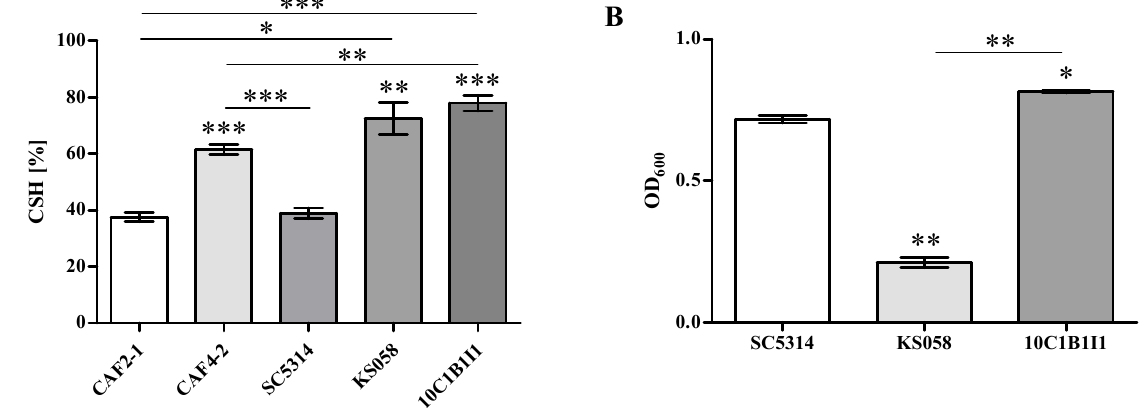
Figure 1. The cell surface hydrophobicity (CSH) and biofilm formation of C. albicans strains. ( A ) CSH (%) of C. albicans strains: CAF2-1 (genotype: ura3 Δ ::imm434 / URA3 ), CAF4-2 (genotype: ura3 Δ ::imm434 / ura3 Δ ::imm434 ; parental strain: CAF2-1), SC5314, KS058 ( erg11 Δ / Δ , parental strain: